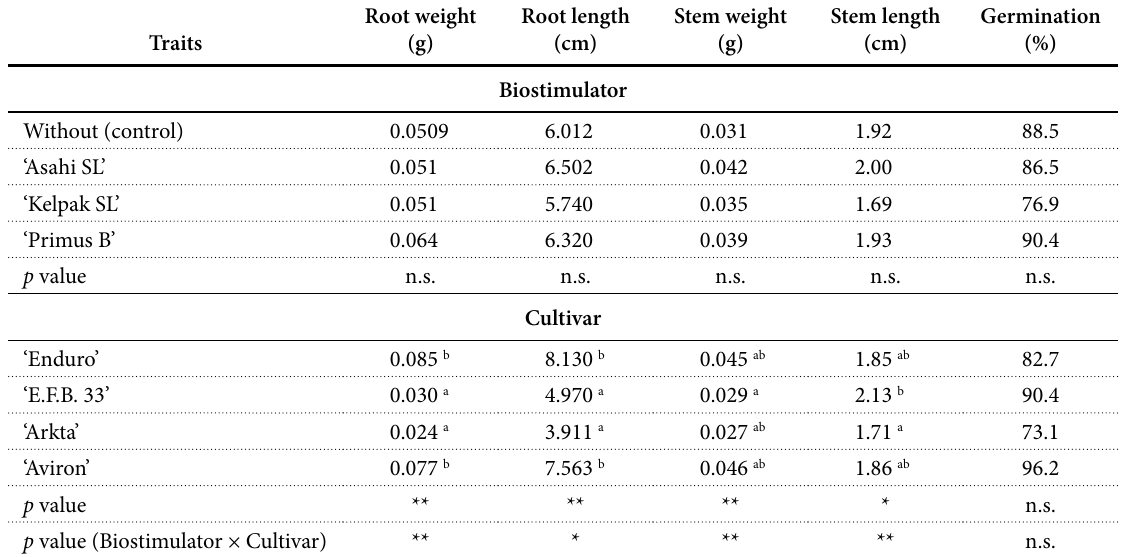
Tab. 1 Characteristics of seedlings dependent on biostimulation application and